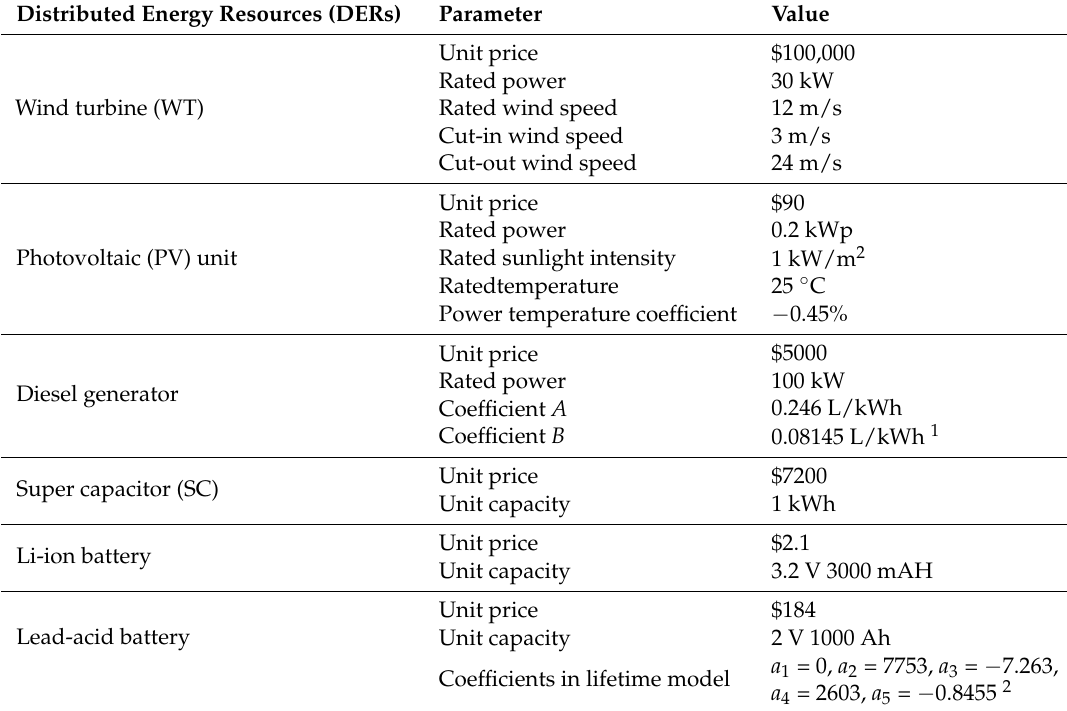
Table 6. Basic parameters of power